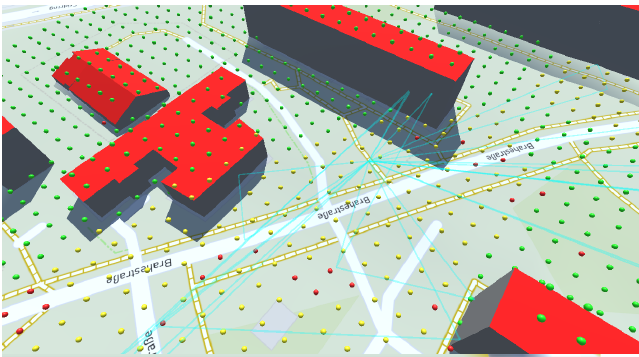
Figure 2. User perspective after scale change. Propagation lines are shown in the last real-scale position, so that propagation can be studied in a larger spatial